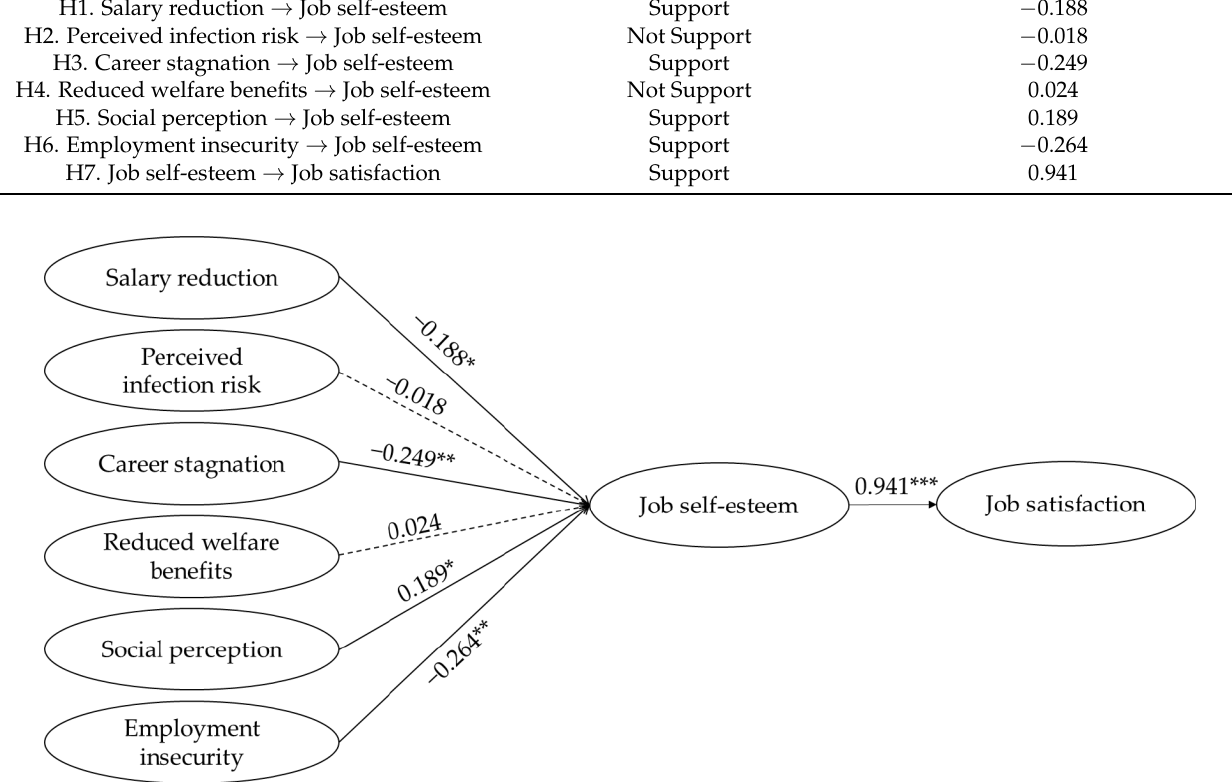
Figure 2. Structural equation model analysis results. Note: * p < 0.05, ** p < 0.01, *** p < 0.001.